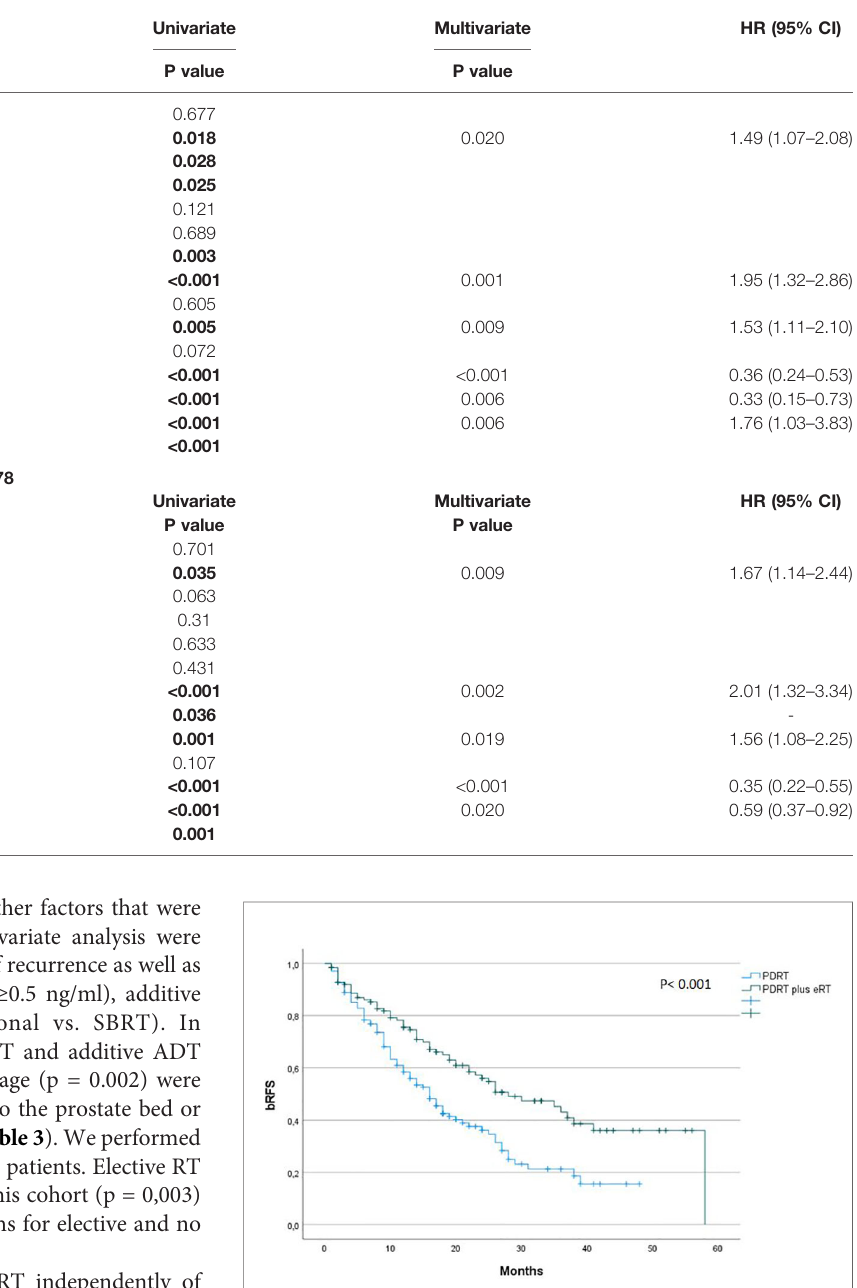
FIGURE 4 | Biochemical recurrence free survival after 68 Ga-PSMA-PET CT- directed radiotherapy of prostate cancer recurrences in patients not receiving ADT strati fi ed by elective RT versus no elective RT. bRFS, Biochemical recurrence free survival; PDRT, PET/CT-directed radiotherapy; eRT, elective radiotherapy.